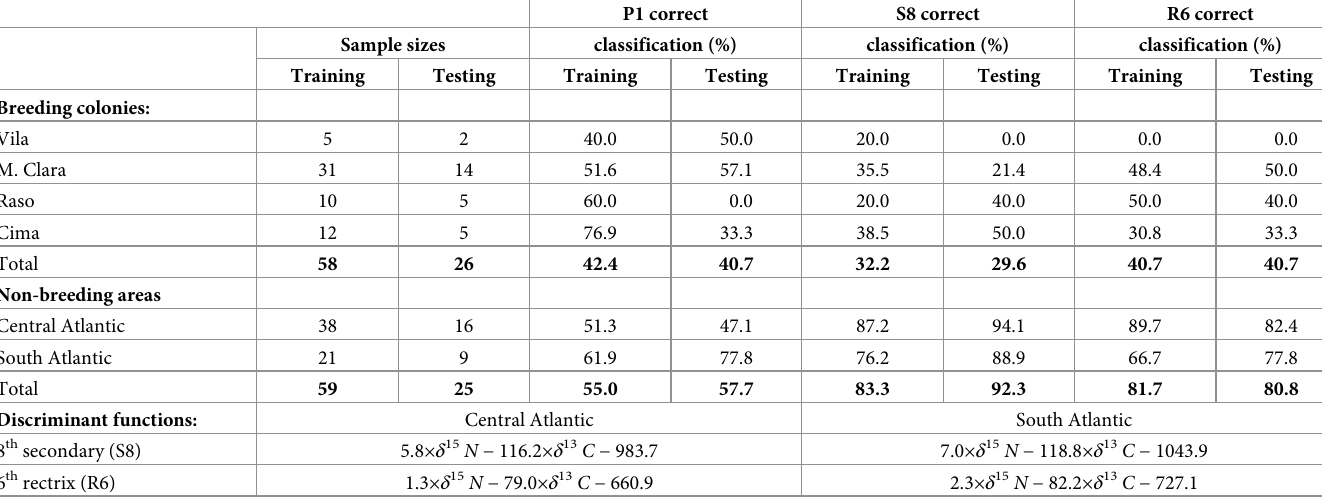
Table 3. Correct classification rates (%) for colonies and non-breeding areas by feather, and discriminant functions using SIA. P1 correct S8 correct R6 correct Sample sizes